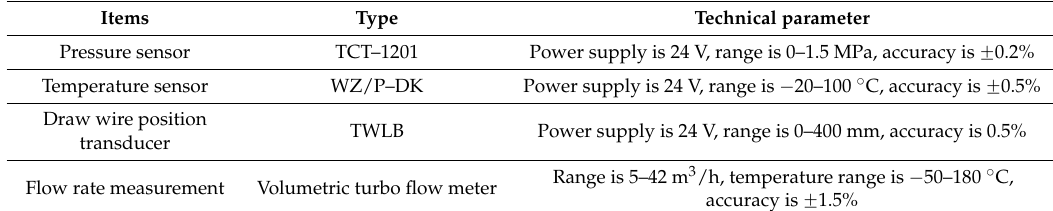
Table 2. The main test instrumentations of the experimental procedure.